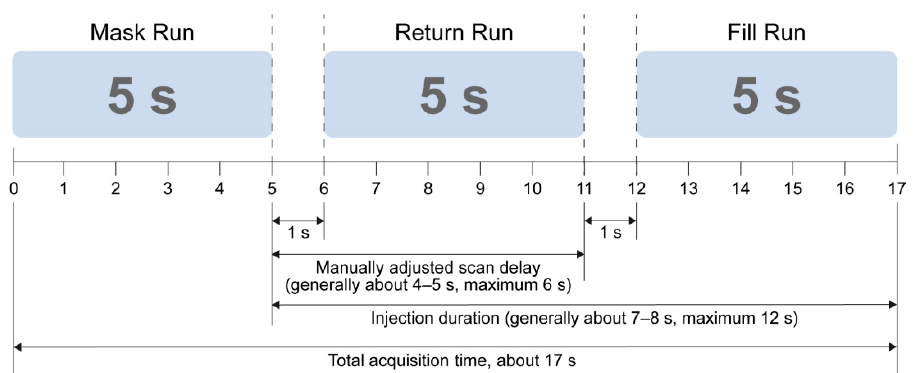
Figure 1. Schematic diagram of parenchymal blood volume (PBV) acquisition time.